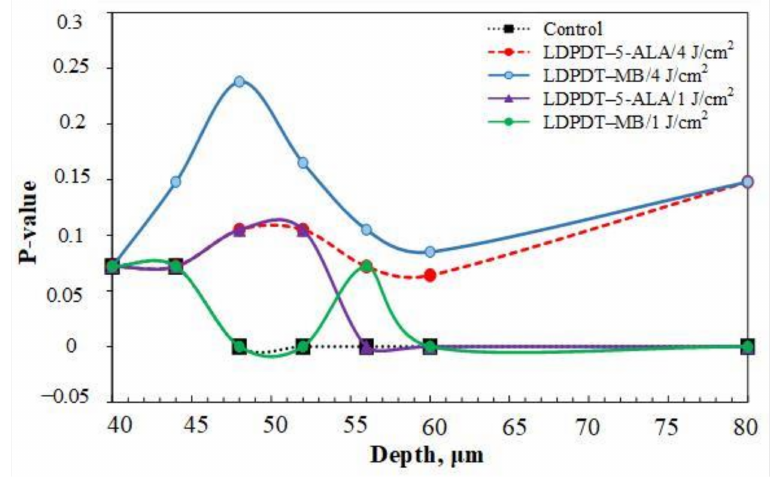
Figure 11. p -values of SAAID for all groups at depths from 40 to 60 µ m and 80 µ m on day 14. It is worth noting that the p -value for LDPDT/4 J/cm 2 was much higher than for the control group, indicating better